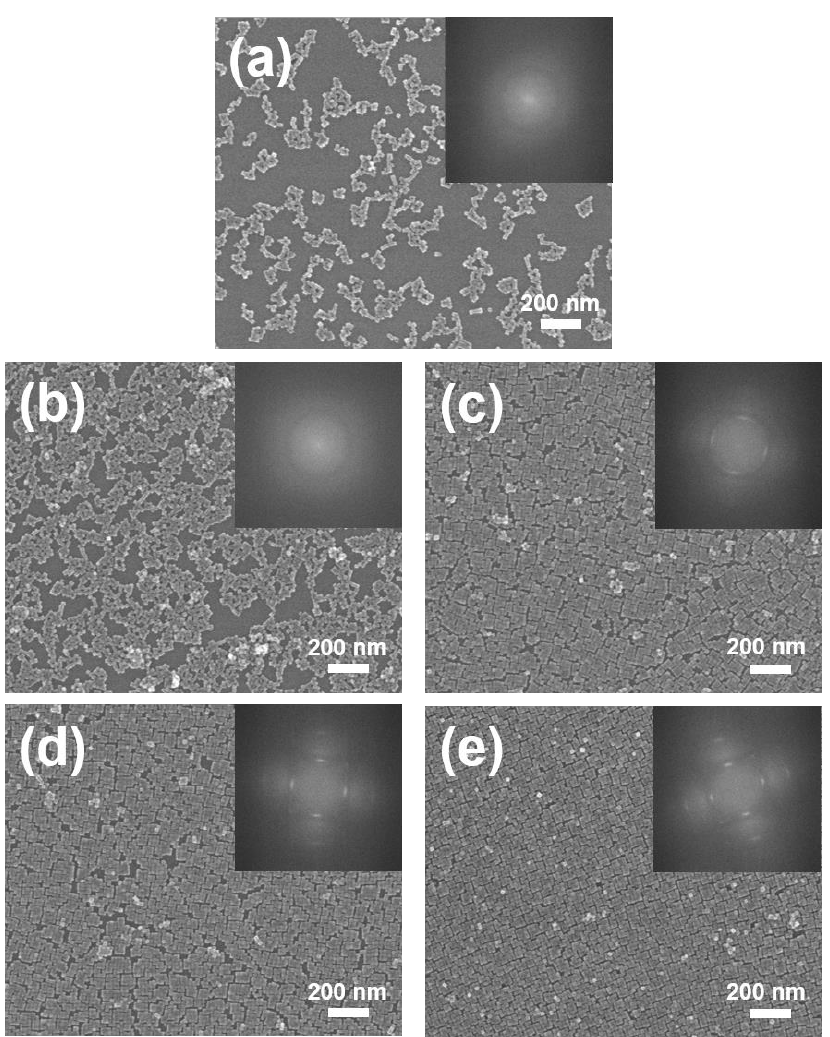
Figure 4. SEM images of BT nanocubes transferred to silicon substrates from water surfaces with the addition of various amounts of oleic acid: ( a ) 0; ( b ) 2.5 × 10 − 10 ; ( c ) 5.0 × 10 − 10 ; ( d ) 1.0 × 10 − 9 , and ( e ) 2.0 × 10 − 9 mol/cm 2 . The insets show the fast Fourier transform (FFT) patterns of the SEM images.